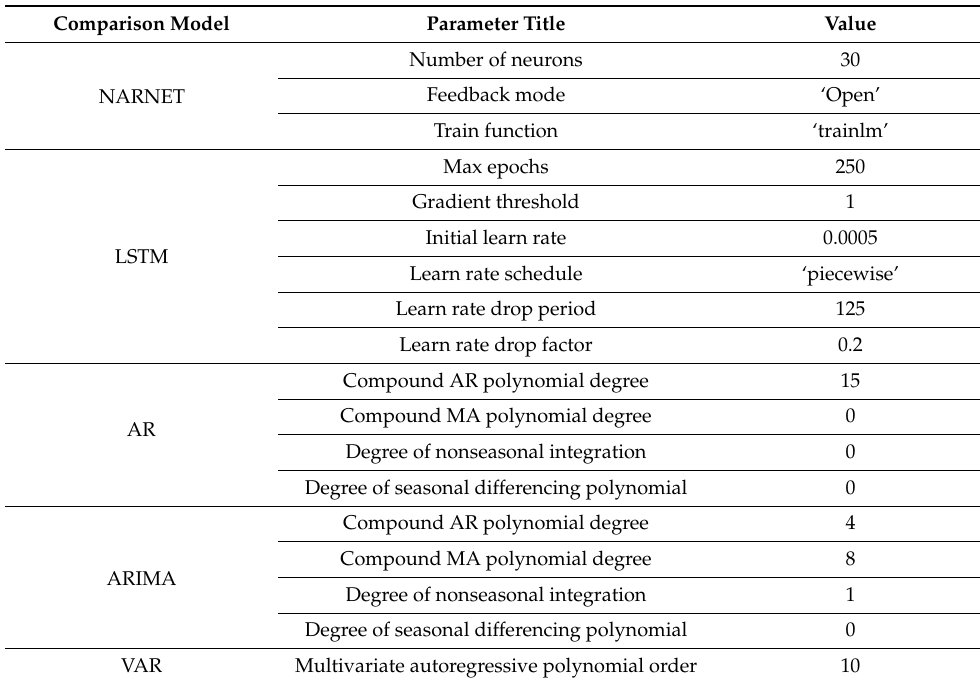
Table 2. The parameter value of comparison